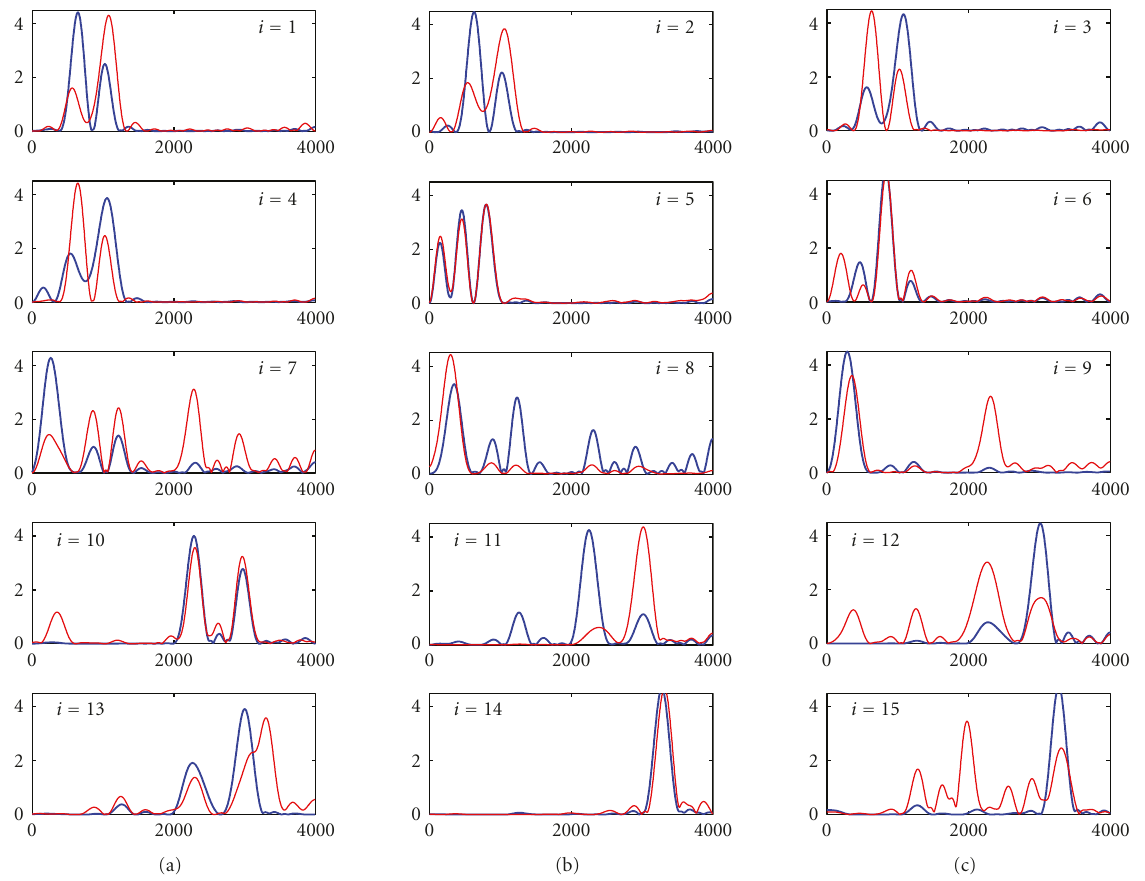
Figure 10: Frequency responses (Magnitude (dB) versus Frequency (Hz)) of the FIR filters for the GSVD algorithm (thick blue lines) and ULLV algorithm (thin red lines) applied to the test problem in Figure 7. Both algorithms compute the MV estimates, and the filters are computed by means of (81) and